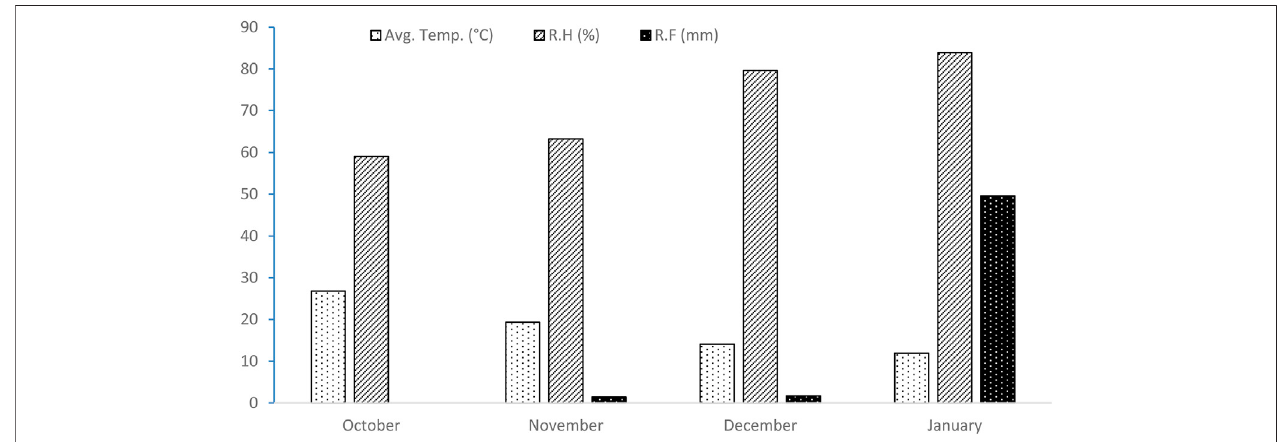
FIGURE 2 | Average temperature (Avg. temp., o C), relative humidity (RH, %), and rainfall (RF, mm) during the growing season of wheat.